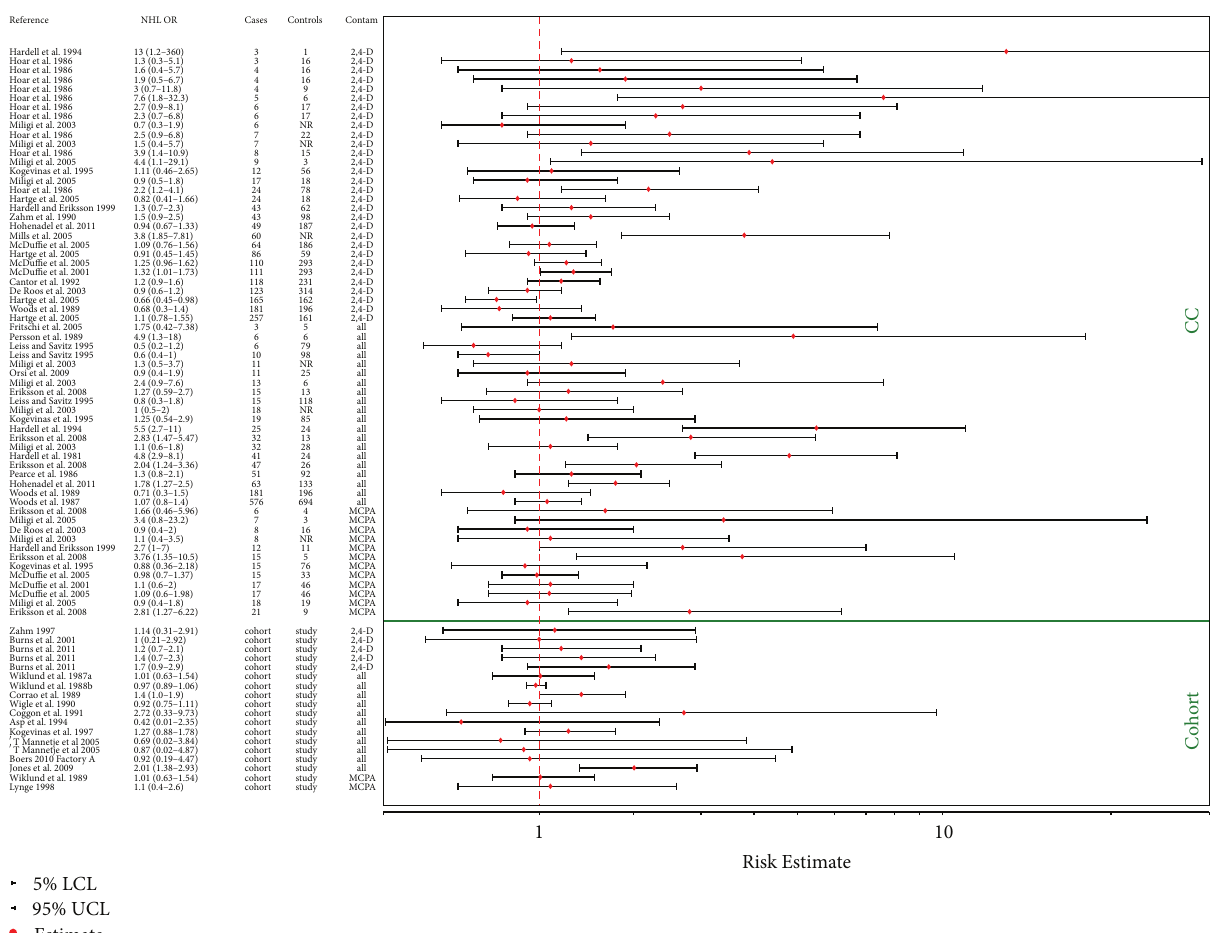
Figure 3: Summary of epidemiologic studies for NHL (see for review [12, 15–17,